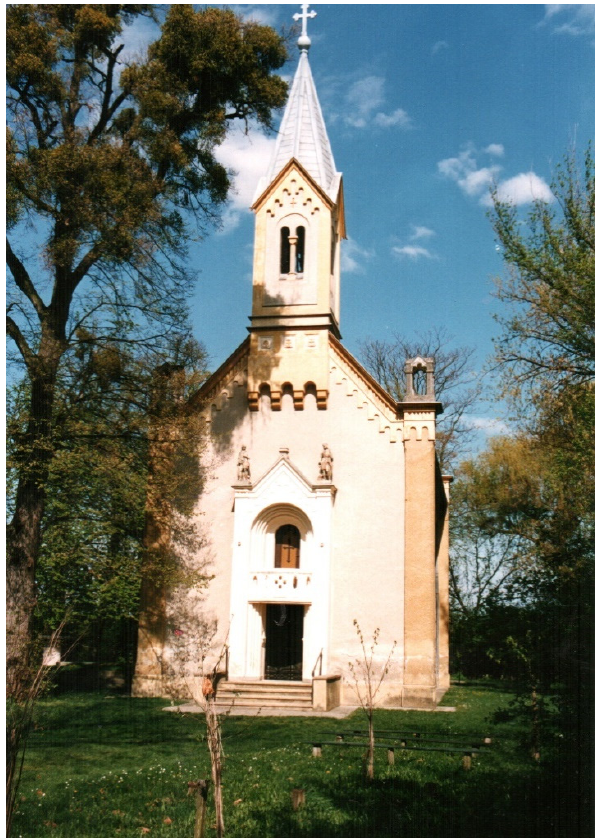
Figure 1. The chapel in Máriakálnok, Photo taken by Krisztina Frauhammer, 2008.